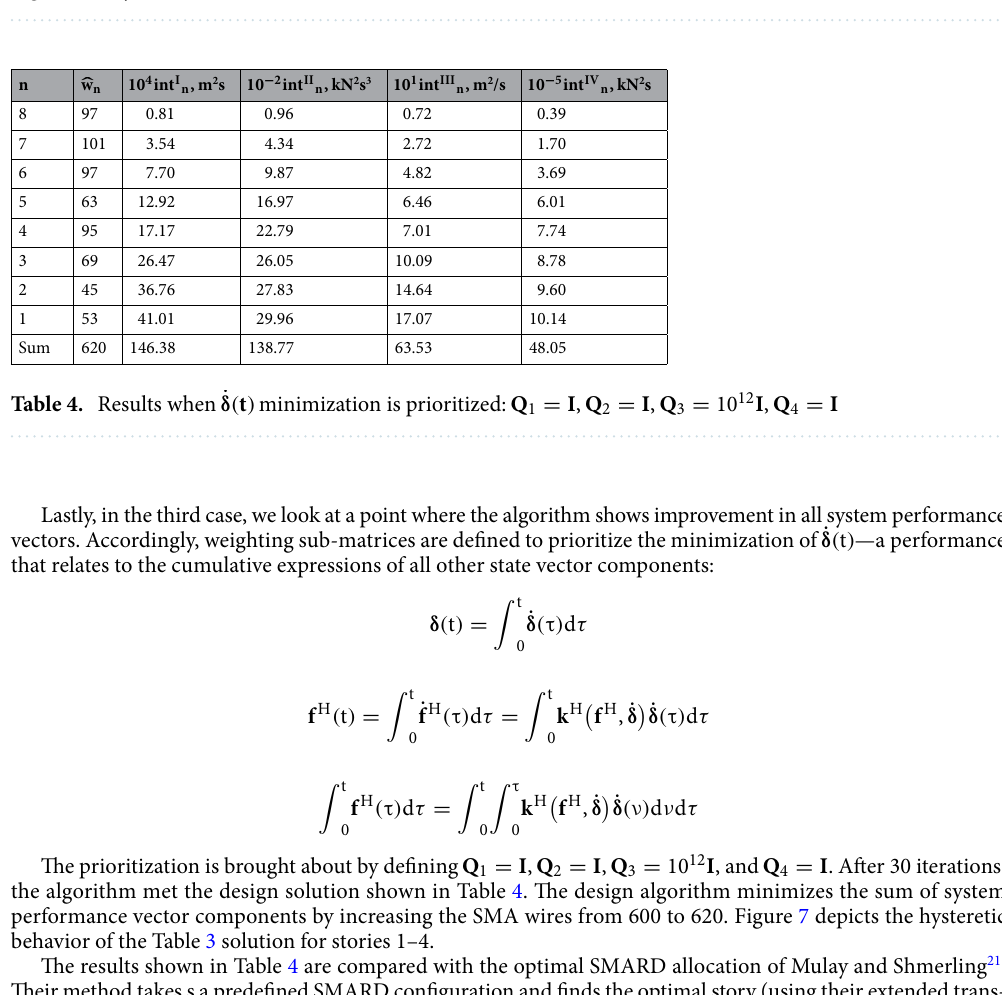
Figure 6. Hysteretic behavior of final SMA allocation with Q 1 = 10